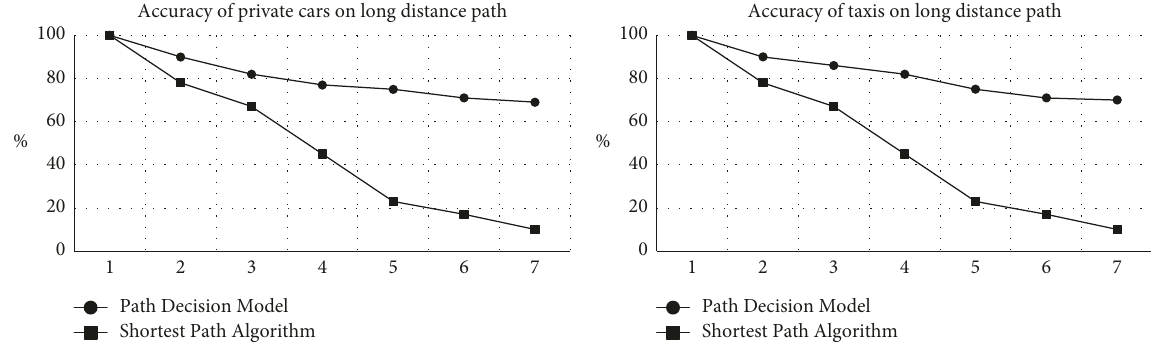
Figure 11: Accuracy of taxis and private cars on the long-distance